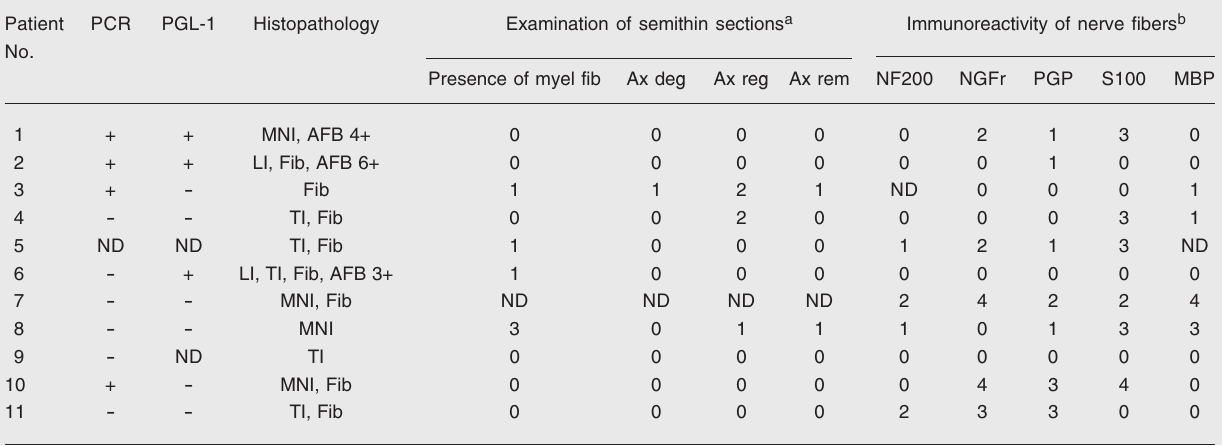
Table 2. Laboratory, histopathological and immunohistochemical data of the leprosy patients studied. Patient PCR PGL-1 Histopathology Examination of semithin sections a Immunoreactivity of nerve fibers b